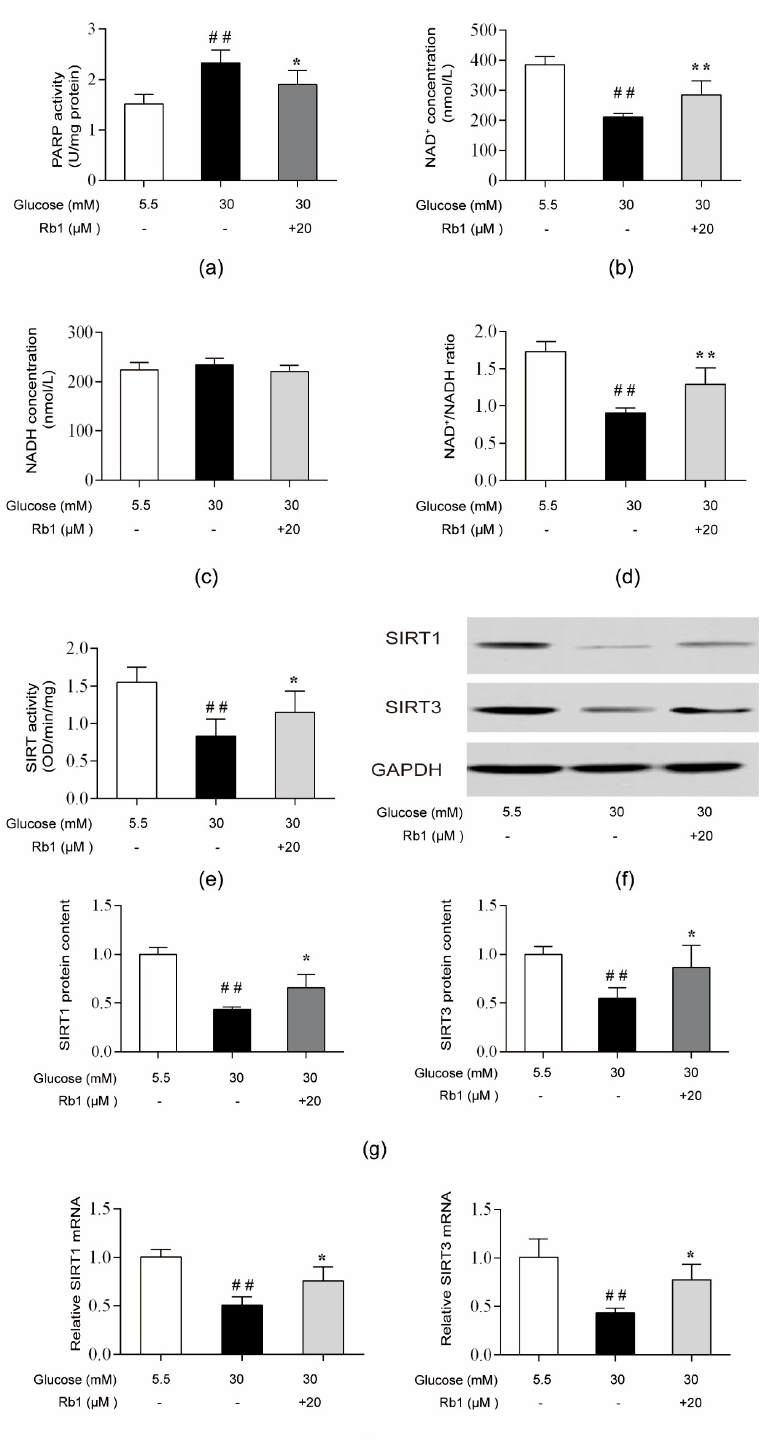
Figure 6. Rb1 prevented the reductions in sirtuin1 (SIRT1), SIRT3, and the nicotinamide adenine dinucleotide (NAD + )/NADH ratio and abrogated the increase in poly(ADP-ribose) polymerase (PARP) in RCECs exposed to high glucose. ( a ) Cells were collected to examine PARP activity. ( b ) NAD + levels. ( c ) NADH levels. ( d ) Intracellular NAD + / NADH ratios. ( e ) Sirtuin activity. ( f ) Western blot analysis was used to determine SIRT1 and SIRT3 protein expression in RCECs. ( g ) The relative densities of SIRT1 and SIRT3 protein expression were determined by image analysis with Image-Pro Plus 6.0 software. ( h ) RT-qPCR was used to measure SIRT1 and SIRT3 mRNA expression. The data are expressed as the means ± SD. ## p < 0.01 versus 5.5 mM glucose; * p < 0.05 and ** p < 0.01 versus 30 mM